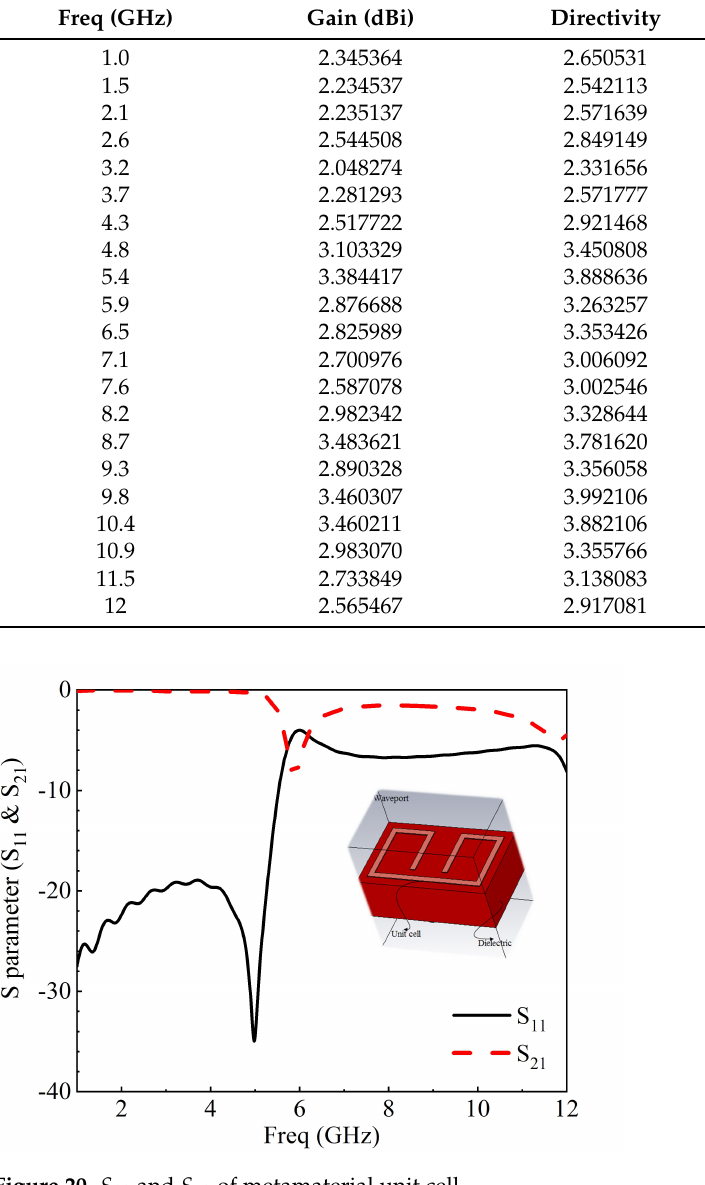
Figure 20. S 11 and S 21 of metamaterial unit